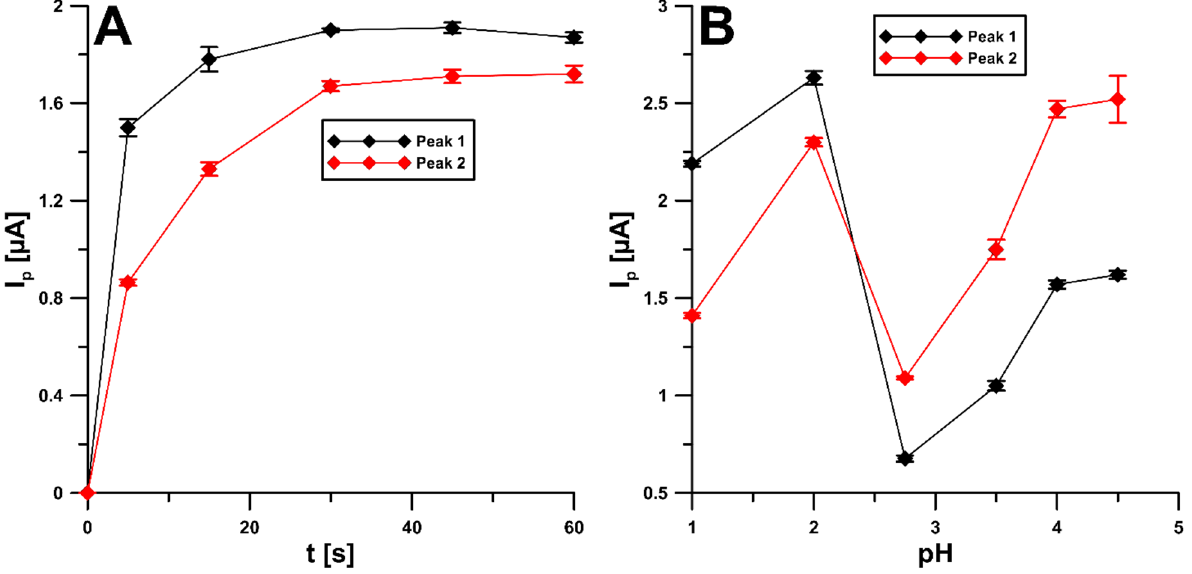
Figure 5. Influence of: ( A ) solution mixing time and ( B ) the type of supporting electrolytes (0.1 and 0.01 M solutions of HNO 3 , 0.1 M CH 3 COOH, and 0.1 M acetate buffers with a pH of 3.5, 4.0, and 4.5) on the 50 nM peak current of NDIT. The mean values of I p are given with the standard deviation for n = 3.